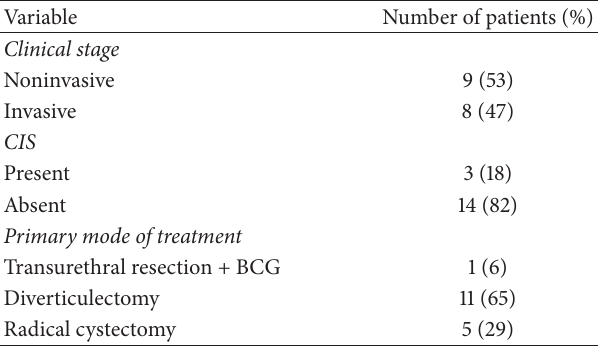
Table 1: Clinicopathological characteristics of